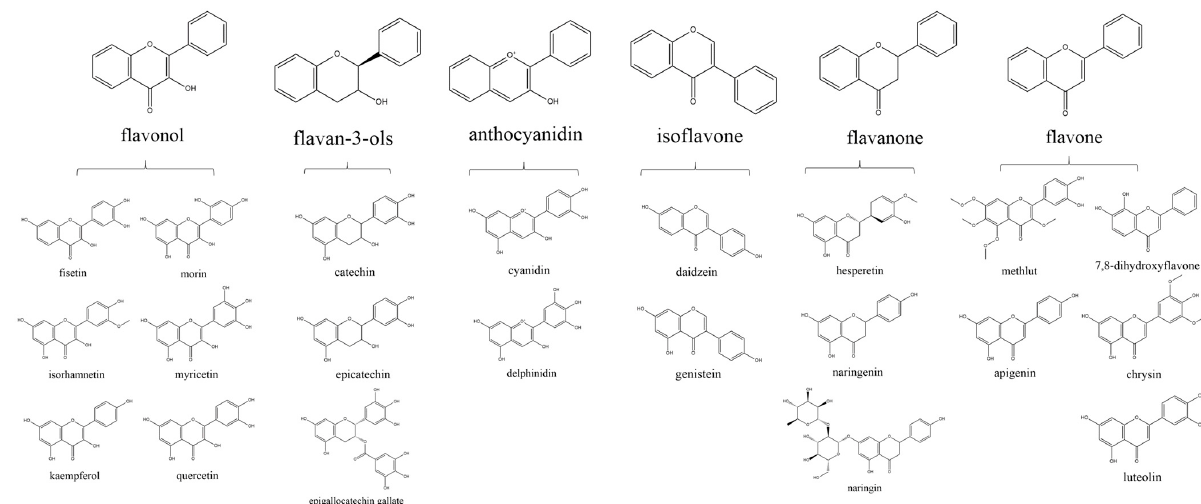
Figure 1. Classification and chemical structures of flavonoids. The chemical structures of typical flavonols (fisetin, isorhamnetin, kaempferol, morin, myricetin, and quercetin), flavan-3-ols (catechin, epicatechin, and epigallocatechin gallate); anthocyanidins (cyanidin and delphinidin), isoflavones (daidzein and genistein), flavanones (hesperetin, naringenin, and naringin), and flavones (methlut, apigenin, luteolin, 7,8-dihydroxyflavone, and chrysin) are shown.